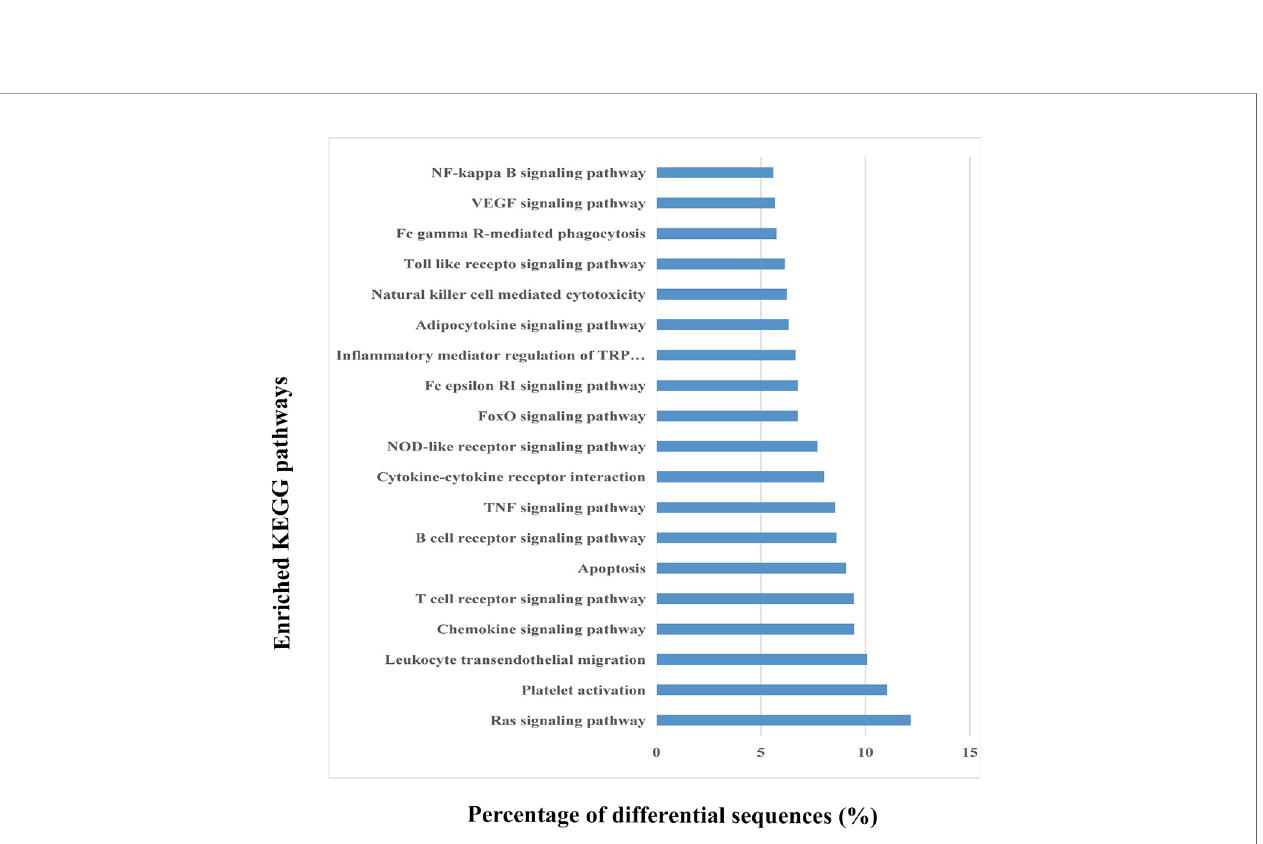
FIGURE 5 | Kyoto Encyclopedia of Genes and Genomes (KEGG) pathway analysis of the differentially expressed EV miRNAs. The top 20 enriched KEGG pathways in the heat-stroked hepatocyte-derived EV-miRNA and the percentages of the sequences involved in each pathway are shown.